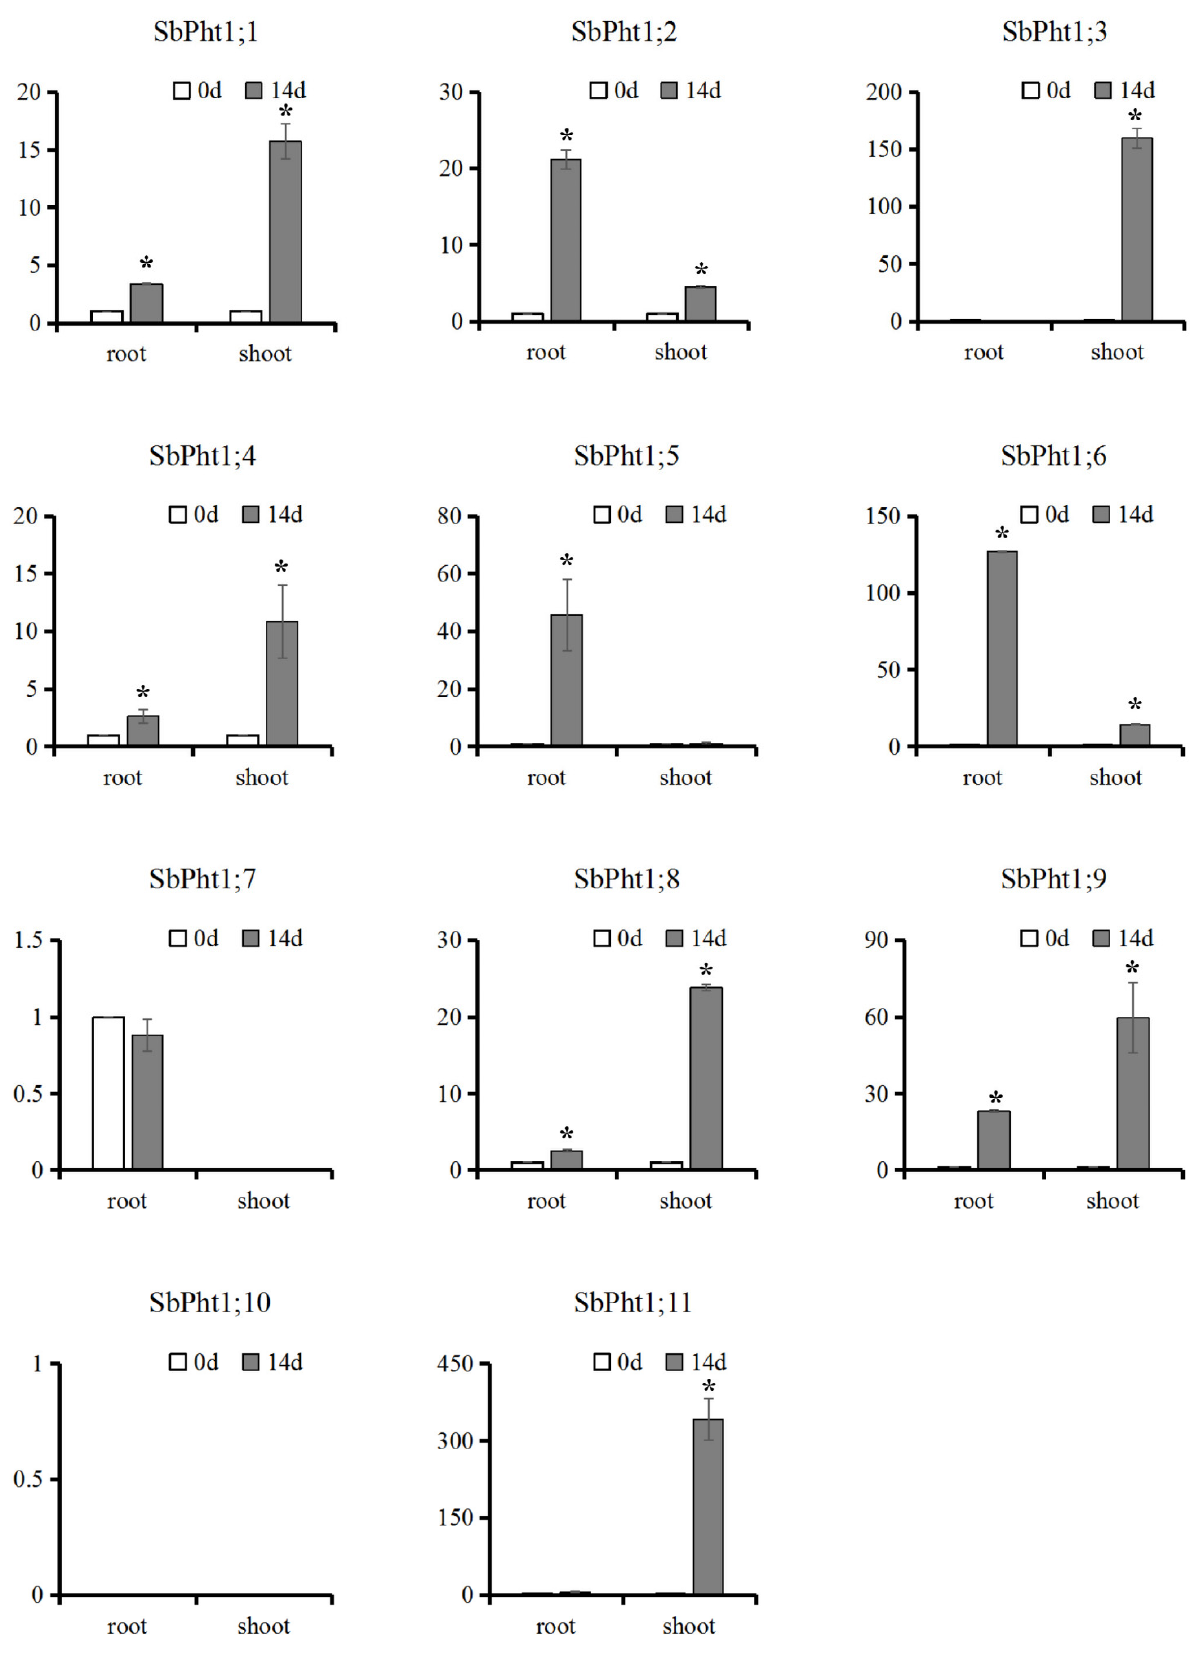
Figure 3. Expression of SbPht1 in root and shoot of sorghum upon low-P stress treatment for 14 days (d). * represents Tukey’s test significance at the threshold of p < 0.01.